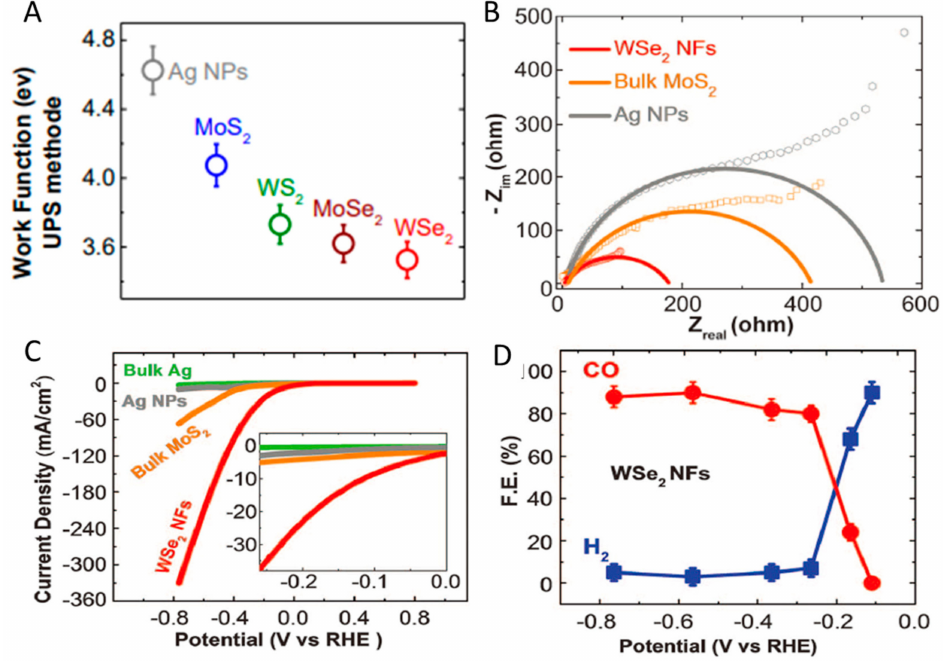
Figure 8. ( A ) Work functions of transition metal dichalcogenides (TMDCs) and Ag NPs; ( B ) CO 2 reductionelectrochemicalimpedancespectroscopy(EIS);( C )Cyclicvoltammetrycurvesand( D )faradaic e ffi ciency curves by applied potential. Reprinted with permission from